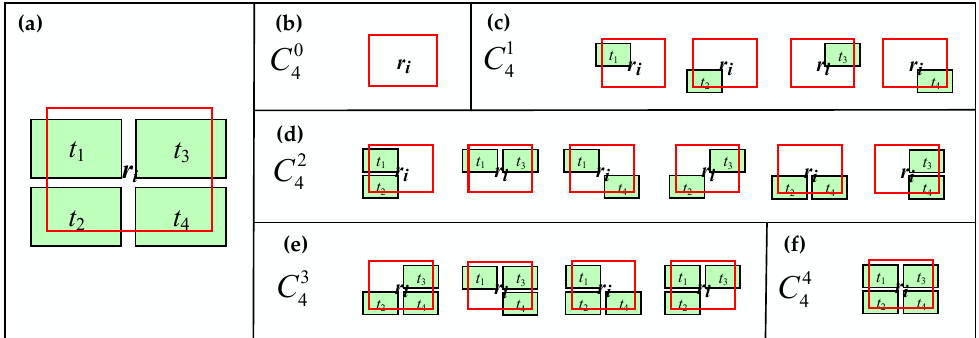
Figure 3. The possible matching combinations of one building object r i : ( a ) one building object r i and its candidate ‐ matching objects t 1 … t 4 ; ( b ) r i matching with none; ( c ) r i matching with one object; ( d ) r i matching with two objects; ( e ) r i matching with three objects; ( f ) r i matching with four objects.